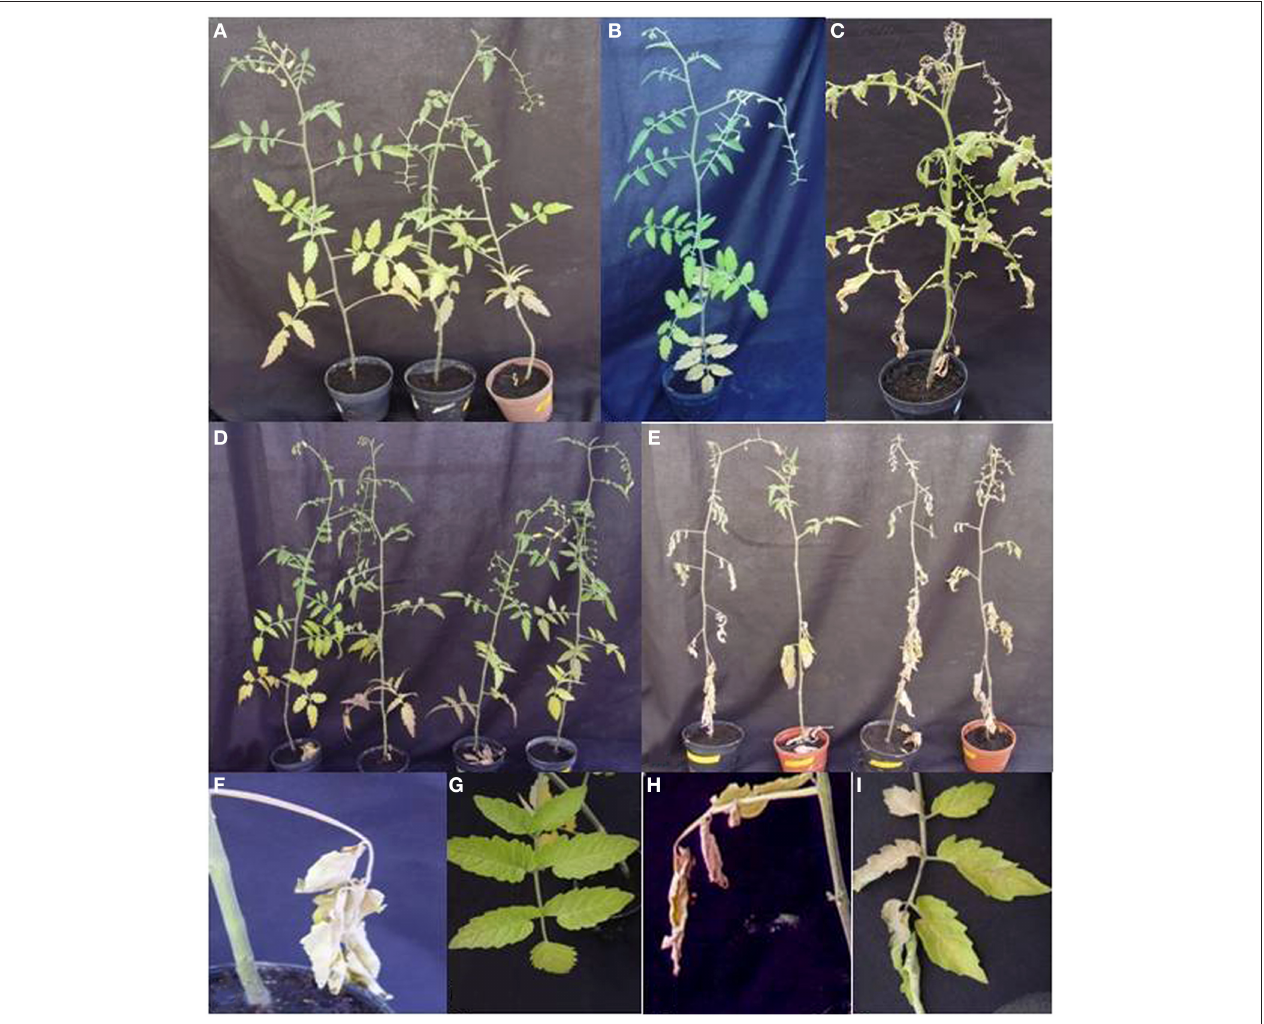
FIGURE 4 | Phenotypes of S. peruvianum and S. lycopersicum plants inoculated with ToMoV VIGS vector prior and 20 days post-infection with Cmm . (A) Phenotype of SCE I-silenced S. peruvianum plant without Cmm inoculation. (B) non-silenced S. peruvianum plant without Cmm inoculation (negative control). (C) non-silenced S. lycopersicum plant inoculated with Cmm . (D) empty vector-treated S. peruvianum plants inoculated with Cmm . (E) SCE I-silenced S. peruvianum plant inoculated with Cmm . (F) Close up of the Cmm infection site on the S. peruvianum leaf for an empty vector-treated plant. (G) Close up of the S. peruvianum